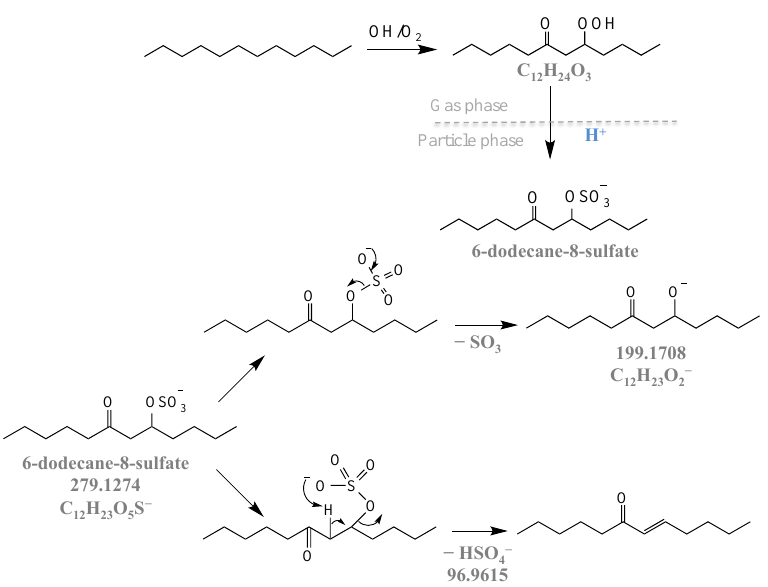
Figure 1. Proposed formation pathway of OS-279 ( m/z 279.1274) and its corresponding fragmentation routes. The suggested mechanism is based on identified products from previous study (Yee et al., 2012).